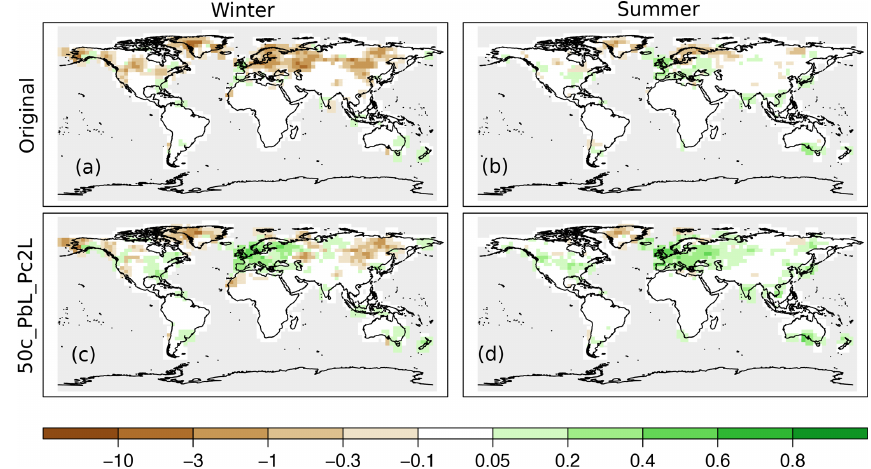
Figure 7. Spatial reconstruction skill of precipitation in terms of RE values, assimilating only instrumental data. Panels (a) and (b) show the skill of the original setup, and (c) and (d) show the result of the 50c_PbL_Pc2L experiment. The skill in the winter season is presented in panels (a) and (c) , and for the summer season in panels (b) and (d)